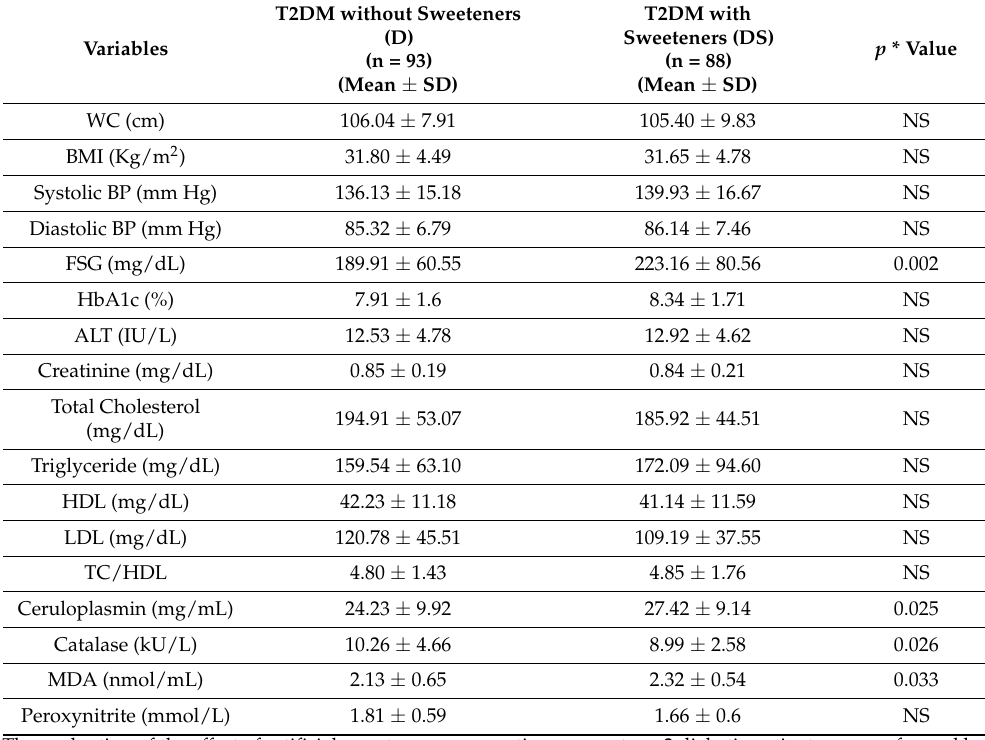
Table 1. Effect of artificial sweetener consumption among diabetic